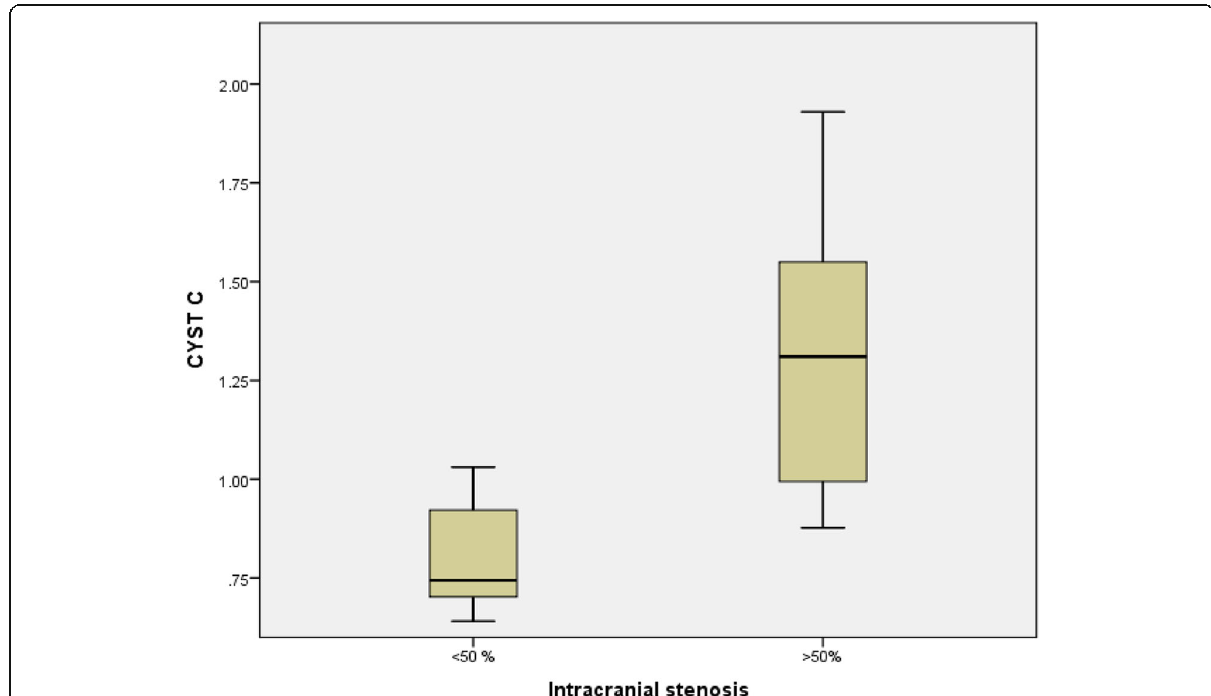
Fig. 3 Cystatin C level (mg/l) in patients with intracranial stenosis according to the degree of stenosis